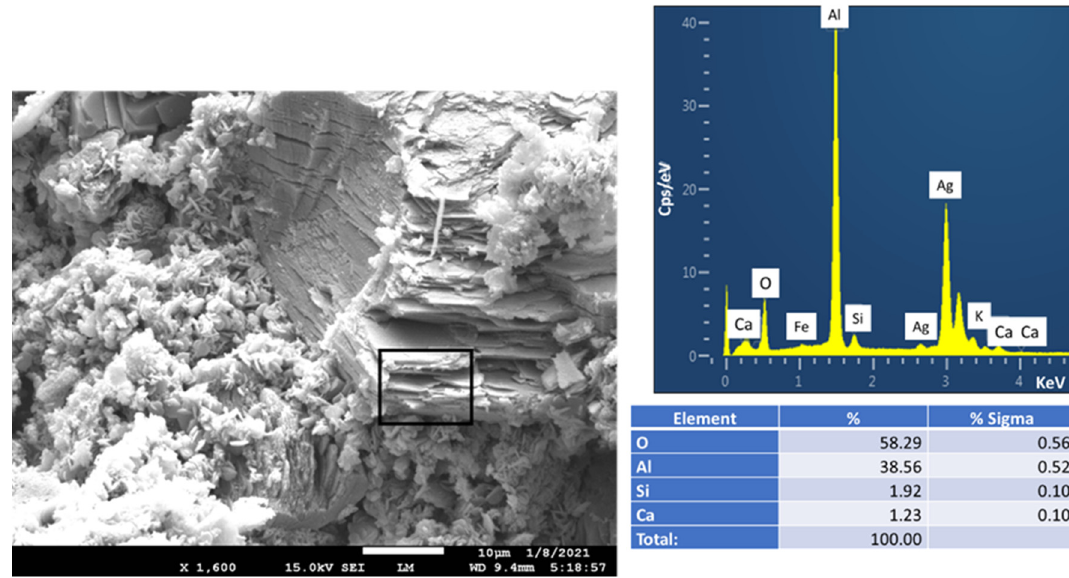
Figure 29. SEM image and EDX elemental composition of CAC blend with 3% PMHS-treated FCSs after autoclaving for 24 h at 250 °C.